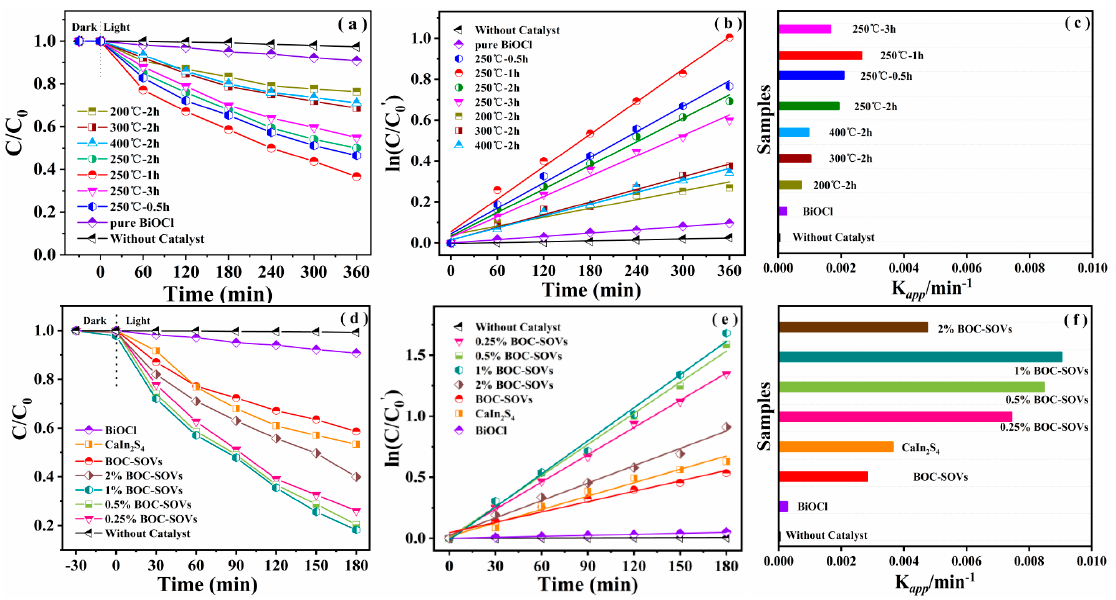
Figure 8. ( a , d ) Photocatalytic degradation curve, ( b , e ) corresponding kinetic curves, and ( c , f ) kinetic rate constant of phenol degradation over different catalysts.